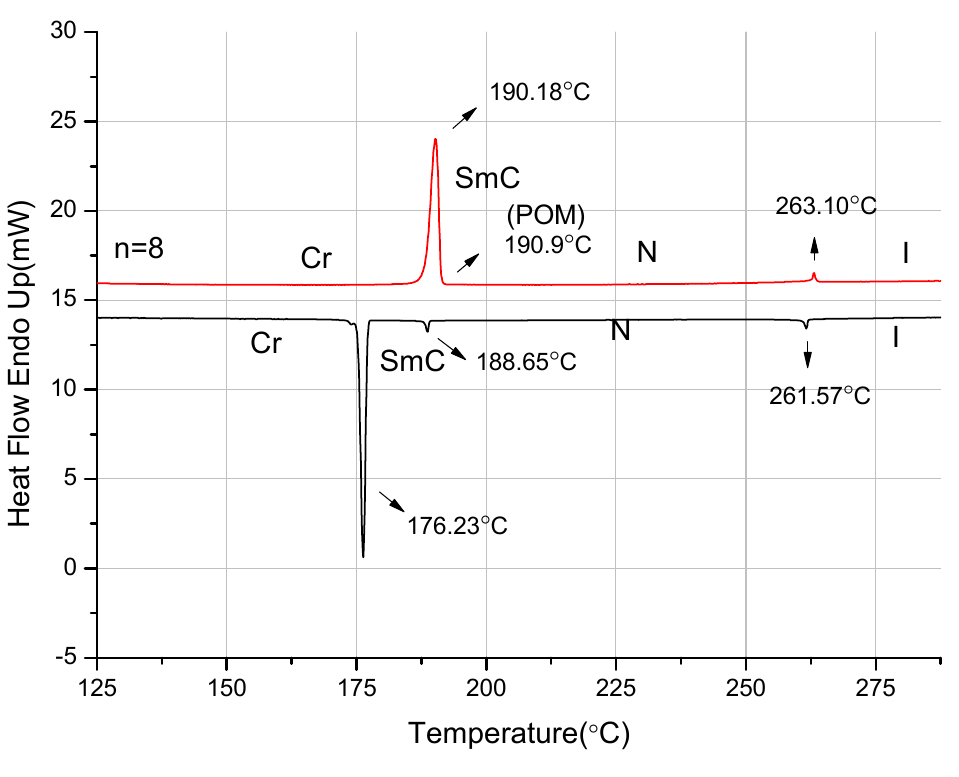
linear interpolation of the data from DSC and POM. Figure 2a,b display the nematic Schlieren texture and the smectic C phase of 8O-PPQMe, respectively. Figure 1. Thermograms of 8O-PPQMe obtained using a second DSC scan under a heating (red) and first cooling (black) rate of 5 °C·min − 1 ; Cr = crystal phases; SmC = smectic C phase; N = nematic phase; I = isotropic phase.